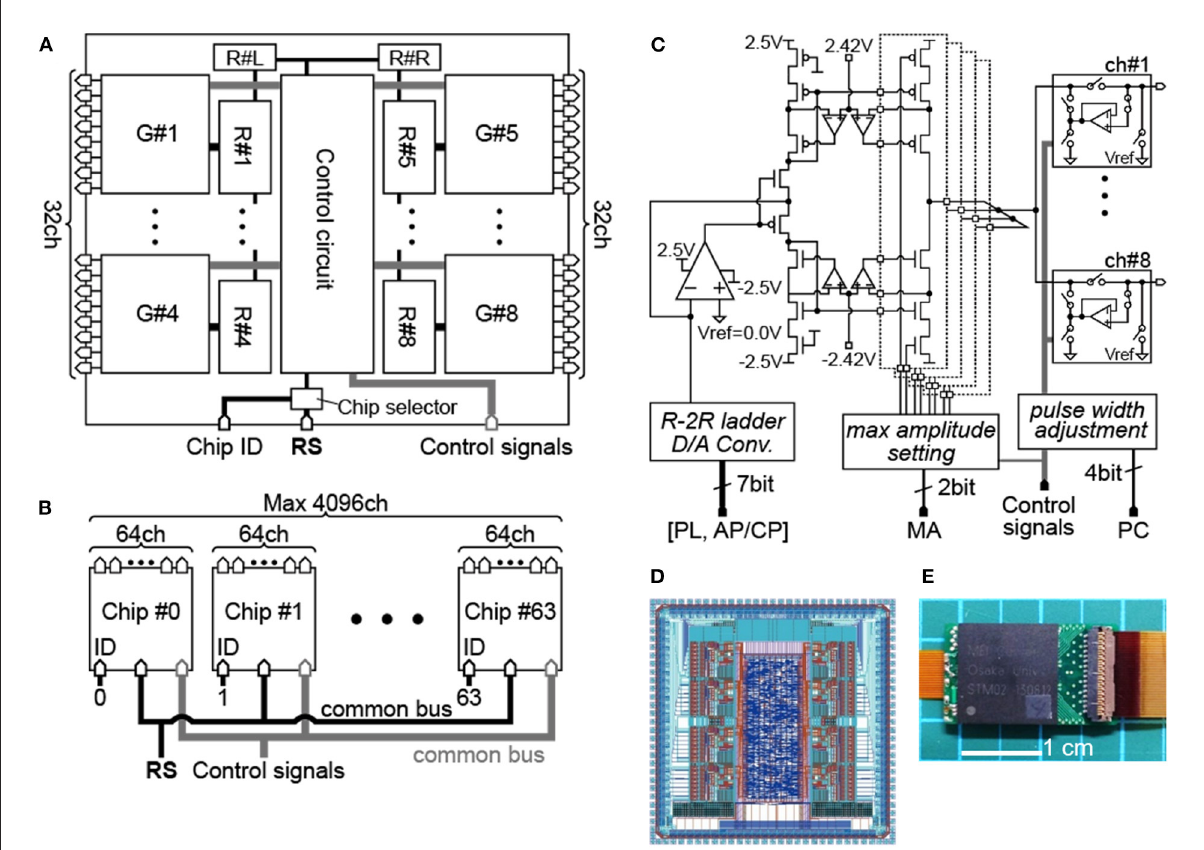
FIGURE1 Design of the stimulation module chip. (A) Block diagram of the module chip. (B) Configuration diagram with the multiple module chips. (C) Schematic diagram of the 8-channel current generator. (D) Layout design of the module chip. (E) Photograph of the packaged chip mounted on a